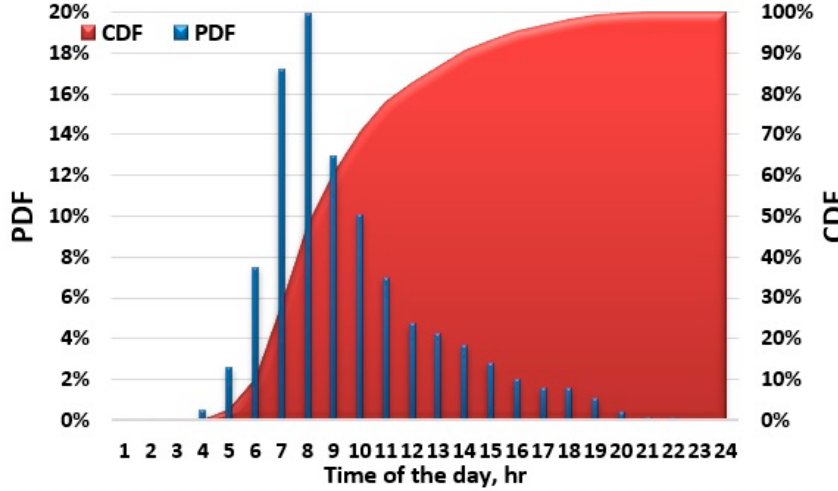
Figure 3. PDF and CDF of departure time from home.